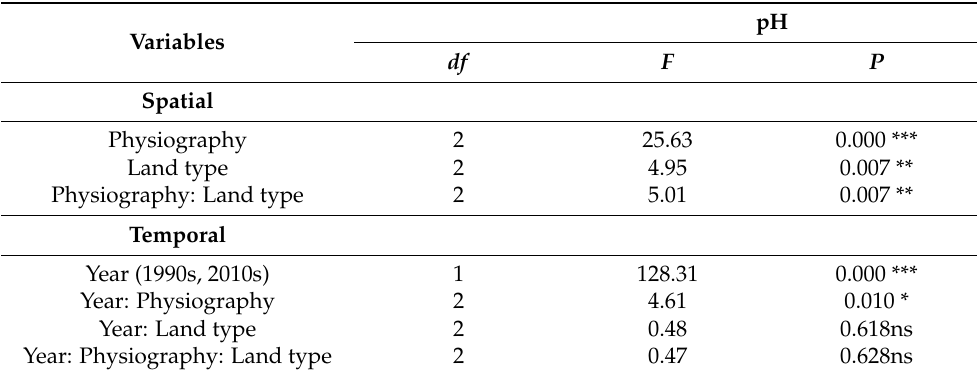
Table 2. Three-way partial factorial model for the main and interactive effects of year, physiography and land types on soil pH between two data collection periods: 1990s and